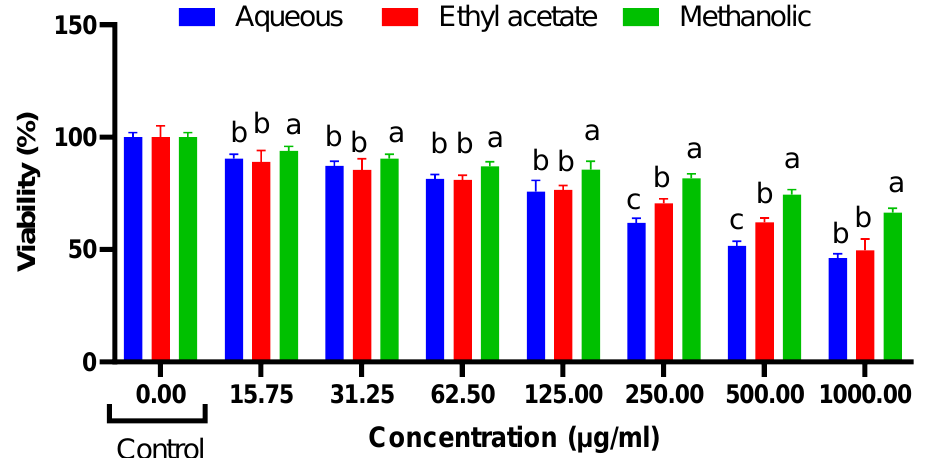
Figure 3. Cell cytotoxicity on HepG2 cells (one-way ANOVA, different letters indicate significant difference between extracts in the same concentration (a, b and c), p ≤ 0.05.).